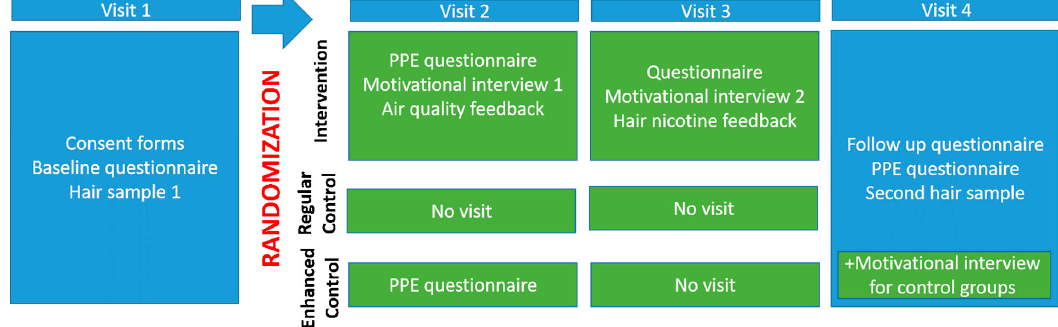
Figure 1. Study protocol by group.